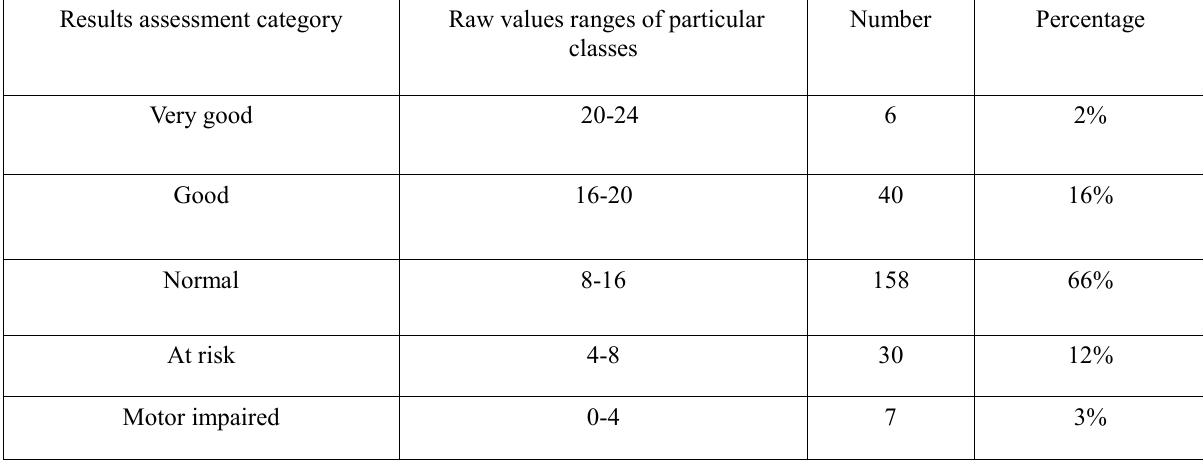
Category structure of results assessment in the modified MOT 4-6 examination – the older group. Set of